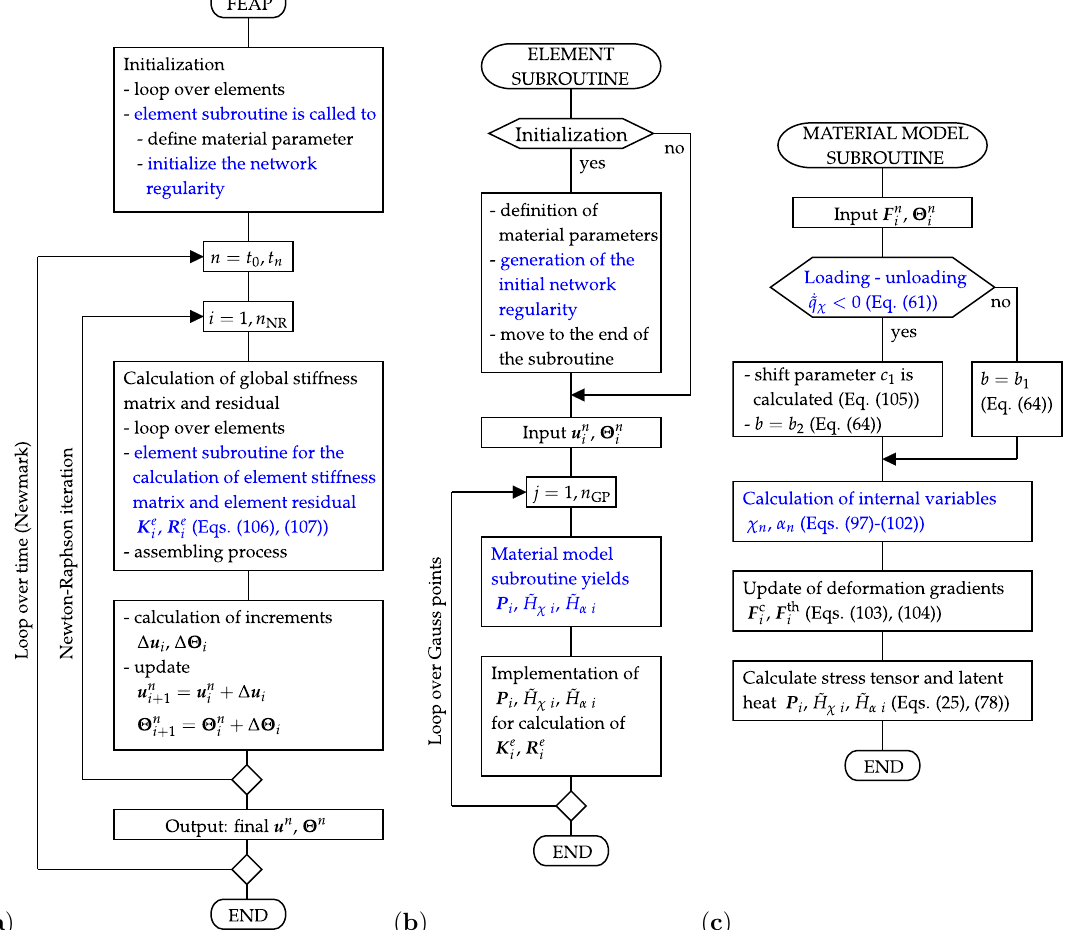
Figure 3. ( a ) Flowchart of the main program, ( b ) flowchart of the element subroutine, ( c ) flowchart of the material model